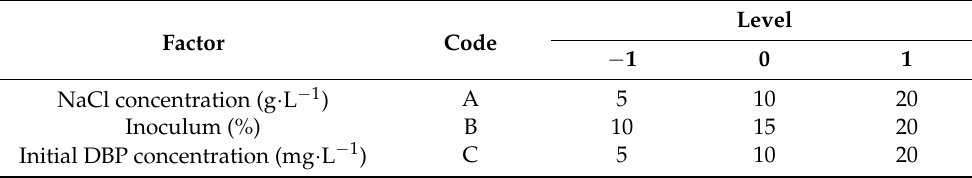
Table 1. Box-Behnken design factor level.